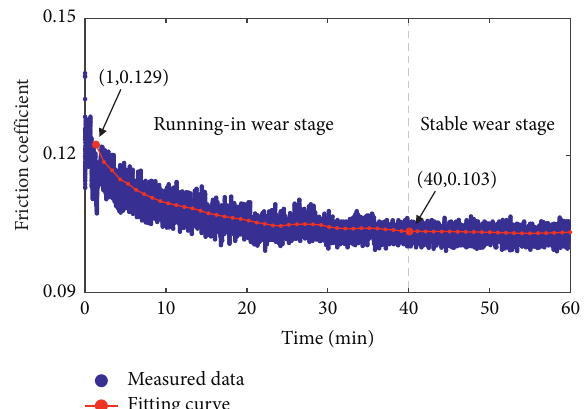
Figure 2: Friction coefficient variation in the running-in experiment.